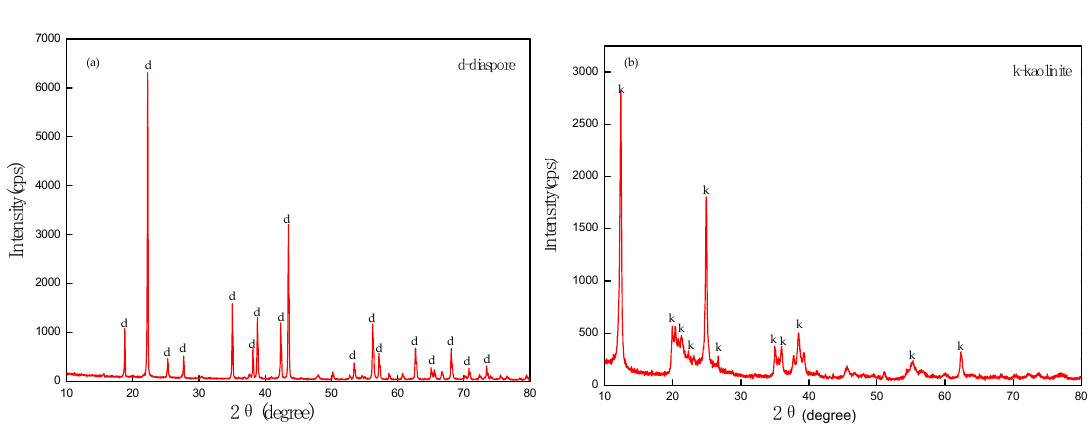
Figure 2. X-ray Diffraction (XRD) results of diaspore ( a ) and kaolinite ( b ). Table 1. Mineral chemical composition analysis results (%).